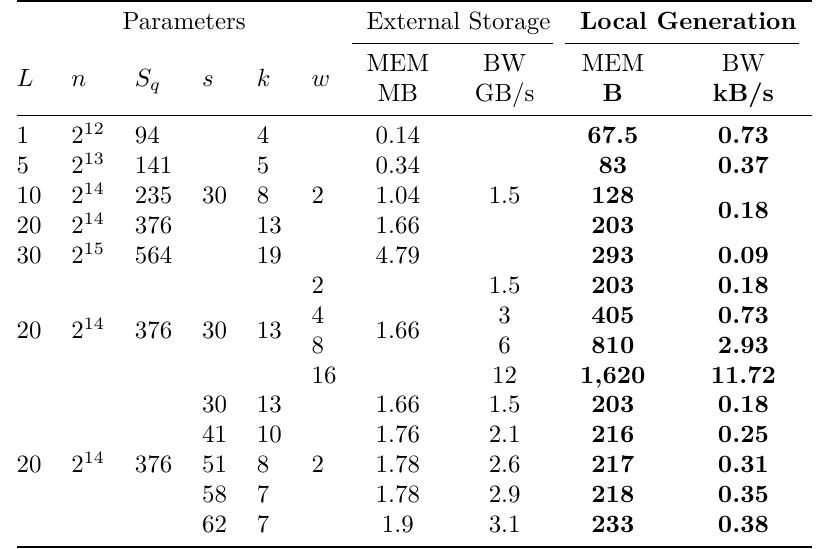
Table 6: Memory footprint and communication bandwidth requirements for external storage strategy and local generation of twiddle